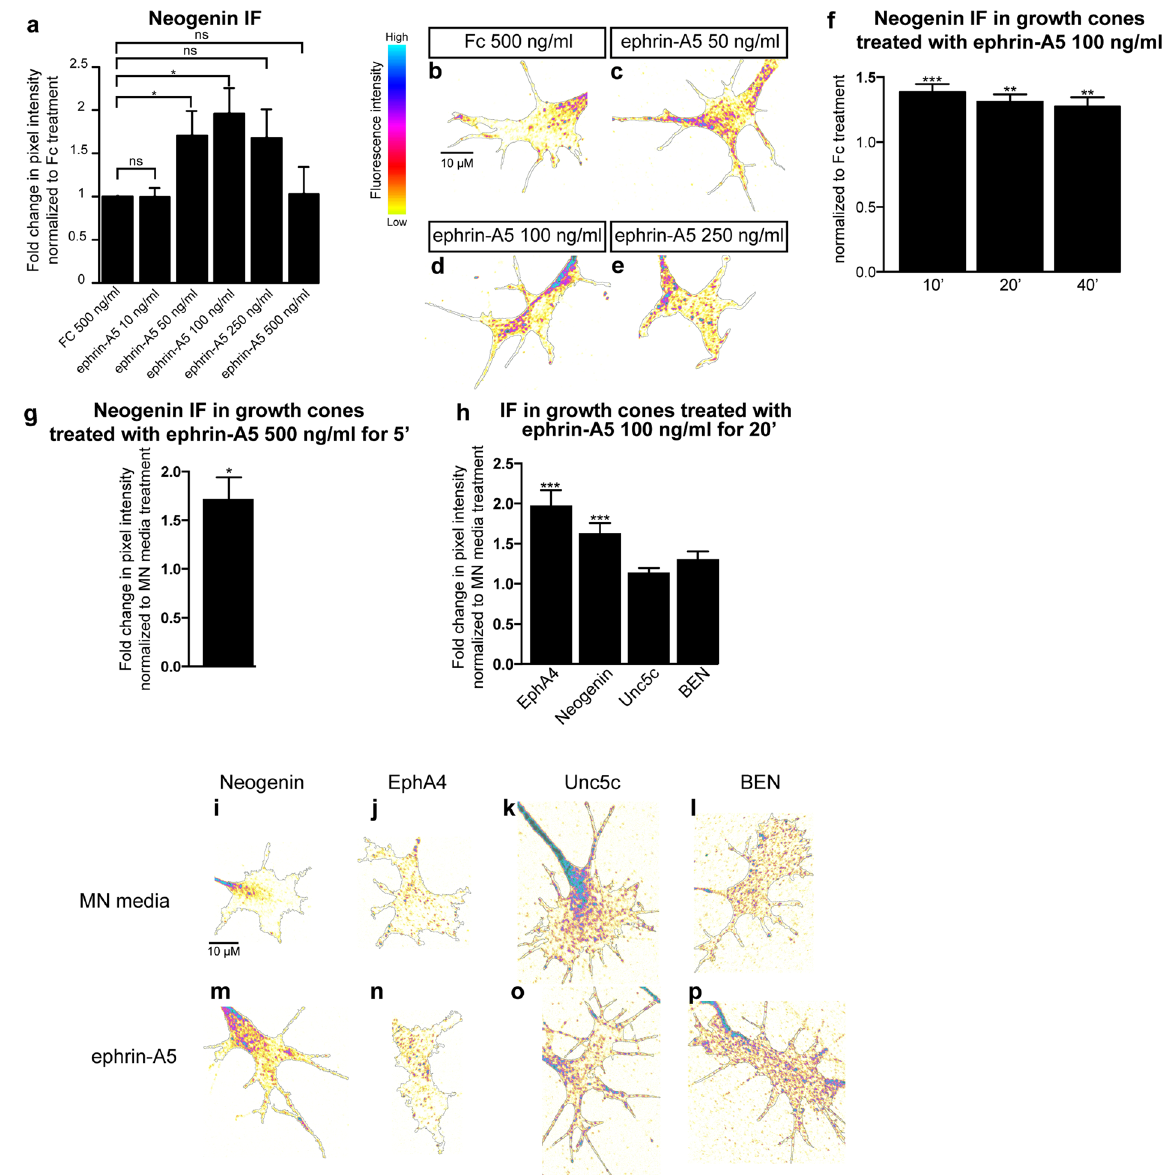
Figure 2. Ephrin-A5 increases Neogenin and EphA4 protein levels in LMC growth cones. ( a ) Mean Neogenin IF in LMC explants treated 15 ′ with either a control solution containing Fc at 500 ng/mL or ephrin-A5 at concentrations ranging from 10 to 500 ng/mL. Ephrin-A5 at 50 and 100 ng/mL results in increased levels of Neogenin IF (ephrin-A5 50 ng/mL: 1.7 ± 0.3-fold, p = 0.038; ephrin-A5 100 ng/mL: 2 ± 0.3-fold, p = 0.011). ( b – e ) Examples of Neogenin IF in growth cones quantified in ( a ). ( f ) Mean Neogenin IF in growth cones of LMC explants treated with either Fc or ephrin-A5 at 100 ng/mL for 10 ′ 20 ′ and 40 ′ . A 10 ′ exposure to ephrin-A5 is sufficient to increase Neogenin IF (1.4 ± 0.1-fold, p = 0.0007) and the increase is maintained after 20 ′ and 40 ′ (1.3 ± 0.1-fold, p = 0.0017; 1.3 ± 0.1-fold, p = 0.0095 respectively). ( g ) A 5 ′ exposure to ephrin-A5 at 100 ng/mL is sufficient for increasing the mean Neogenin IF in LMC growth cones (1.7 ± 0.2-fold, p = 0.0228). ( h ) Quantification of mean Neogenin, EphA4, Unc5c and BEN IF levels in growth cones exposed to either MN media or ephrin-A5 at 100 ng/mL for 20 ′ . Ephrin-A5 induced an increase in Neogenin and EphA4 IF (1.6 ± 0.1- fold, p < 0.0001; 2 ± 0.2-fold, p = 0.0001 respectively), Unc5c and BEN IF levels did not significantly differ (p = 0.0806 and p = 0.1391 respectively). ( i , p ) Examples of growth cones quantified in ( h ). Data are shown as mean ± SEM, statistical significance was tested using a two-tailed unpaired sample t-test. ( a ) Fc 500 ng/mL N = 5, ephrin-A5 10 ng/mL N = 3, eprhrin-A5 50 ng/mL N = 5, ephrin-A5 100 ng/mL N = 5, ephrin-A5 250 ng/ mL N = 5, ephrin-A5 500 ng/mL N = 3; ( f ) Fc 100 ng/mL 40 ′ N = 4,ephrin-A5 100 ng/mL 10 ′ N = 4, ephrin-A5 100 ng/mL 20 ′ N = 4, ephrin-A5 100 ng/mL 40 ′ N = 4; ( g ) Fc 500 ng/mL 5 ′ N = 4, ephrin-A5 500 ng/mL 5 ′ N = 4; n: EphA4 N = 16, Neogenin N = 13, BEN N = 5, Unc5c N = 10. Values for the total number of growth cones and SEM values for each treatment for this figure and subsequent figures are provided in the Supplementary Excel